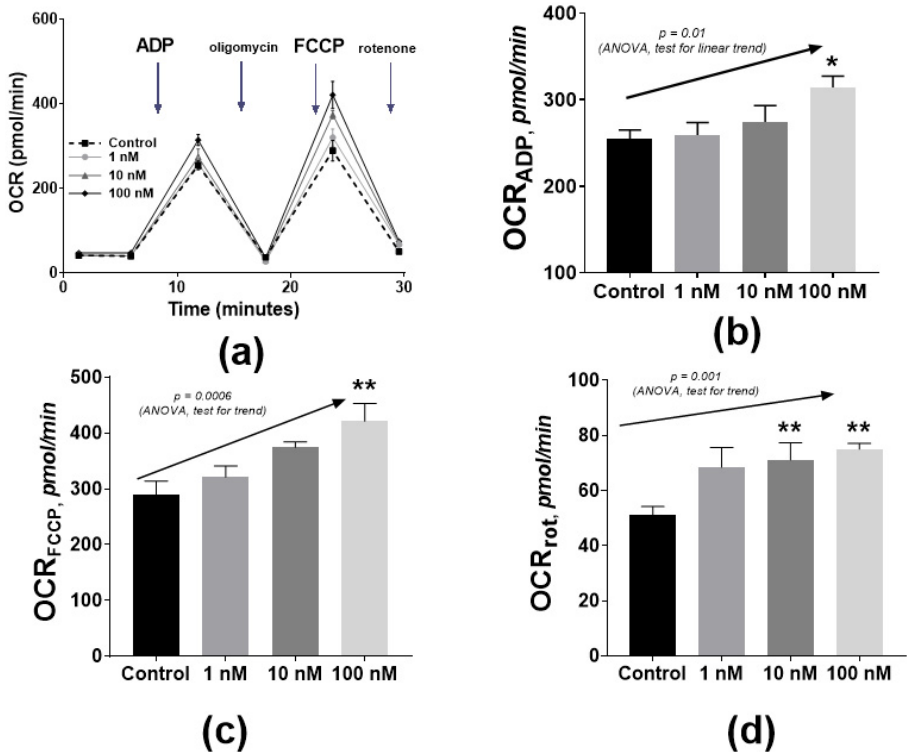
Figure 5. The influence of 4i on complex I (glutamate–malate)-dependent oxygen consumption rate. (OCR): OCR profile plot ( a ), ADP-linked respiration ( b ), maximal FCCP-linked respiration ( c ), and rotenone-dependent respiration ( d ). ( b – d ) plots are means and SEM; * p ≤ 0.05, ** p ≤ 0.01 from ANOVA and post-hoc Dunnett’s test. The concentration dependence was proposed according to the post-hoc linear trend test (arrows with p -values).